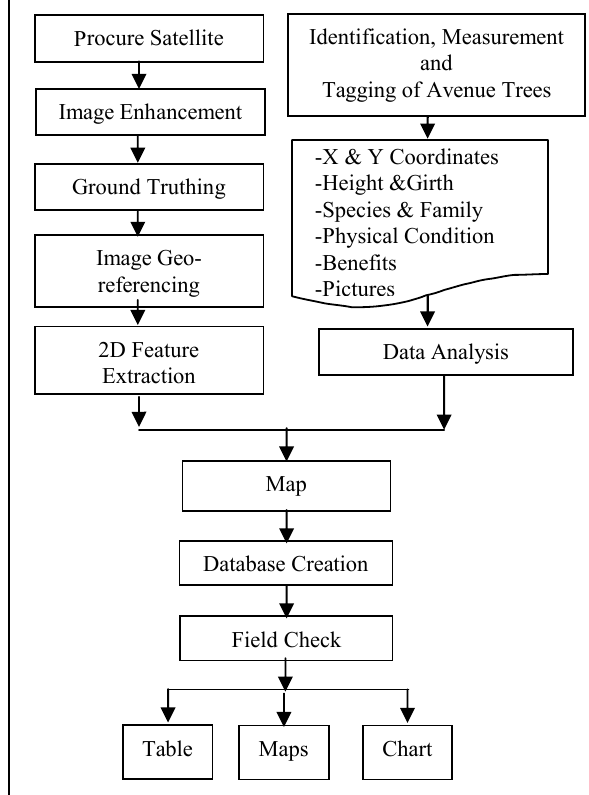
Figure 2. Flow Chart of the Research Methodology